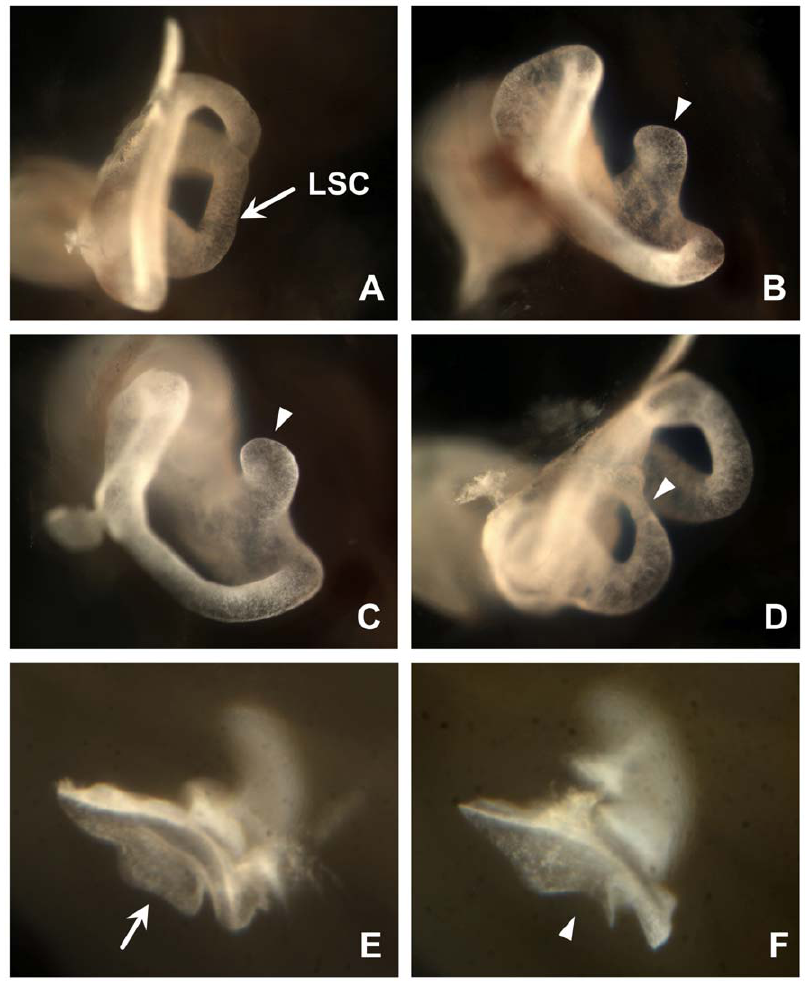
Figure 1. CSS-14 circlers exhibit malformation of the lateral semicircular canal. (A) Inner ear morphology of CSS-14 mice was assessed at P0 using a standard paintfill technique. Chr14 B10/SWR mice do not circle and have intact LSCs (arrow). (B–D) 50% of inner ears from Chr14 SWR/SWR mice exhibit truncation (B,C) or severe distortion (D) of the LSC (arrowheads), while the anterior and posterior canals are unaffected. (E) Paintfilling was also used to assess canal pouch morphology of CSS-14 embryos at E12.25. Lateral canal pouches of Chr14 B10/SWR embryos exhibit normal morphology (arrow). (F) Lateral pouches from E12.25 Chr14 SWR/SWR embryos are abnormally-shaped and lack the distal rim necessary for proper LSC formation